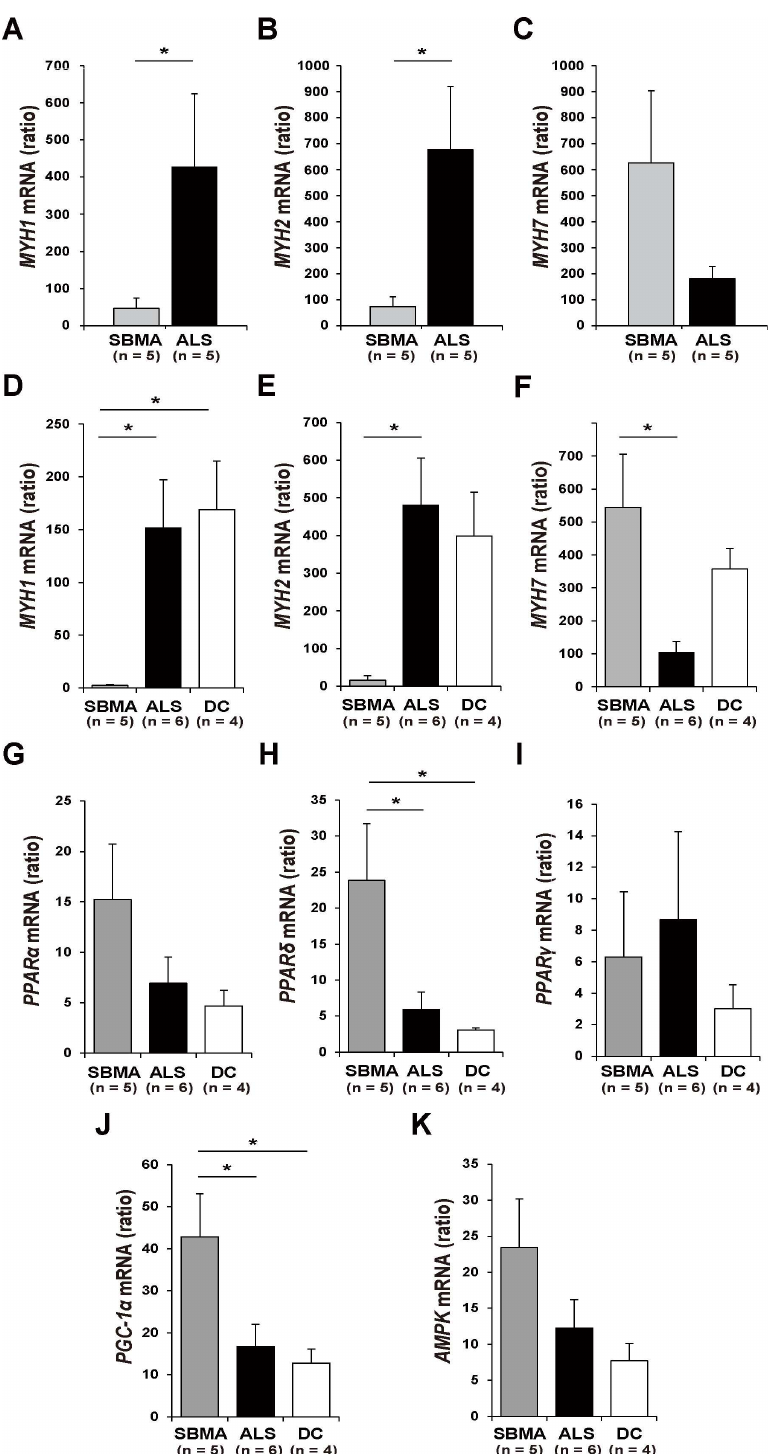
Fig 5. Expression levels of myosin heavy chain and AMPK-PGC-1 α pathway in the skeletal muscles. The mRNA expressionlevels of MYH1 (encodingMHC type IIx), MYH2 (encodingMHC type IIa), and MYH7 (encoding MHC type I) normalizedto β 2-microglobulin levels in the intercostalmuscles of SBMA ( n = 5) and ALS ( n = 5) subjects(A–C). The expressionlevels of MYH1 (A) and MYH2 (B) were significantly decreased in subjectswith SBMA comparedwith subjects with ALS. The mRNA expressionlevels of MYH1 , MYH2 ,